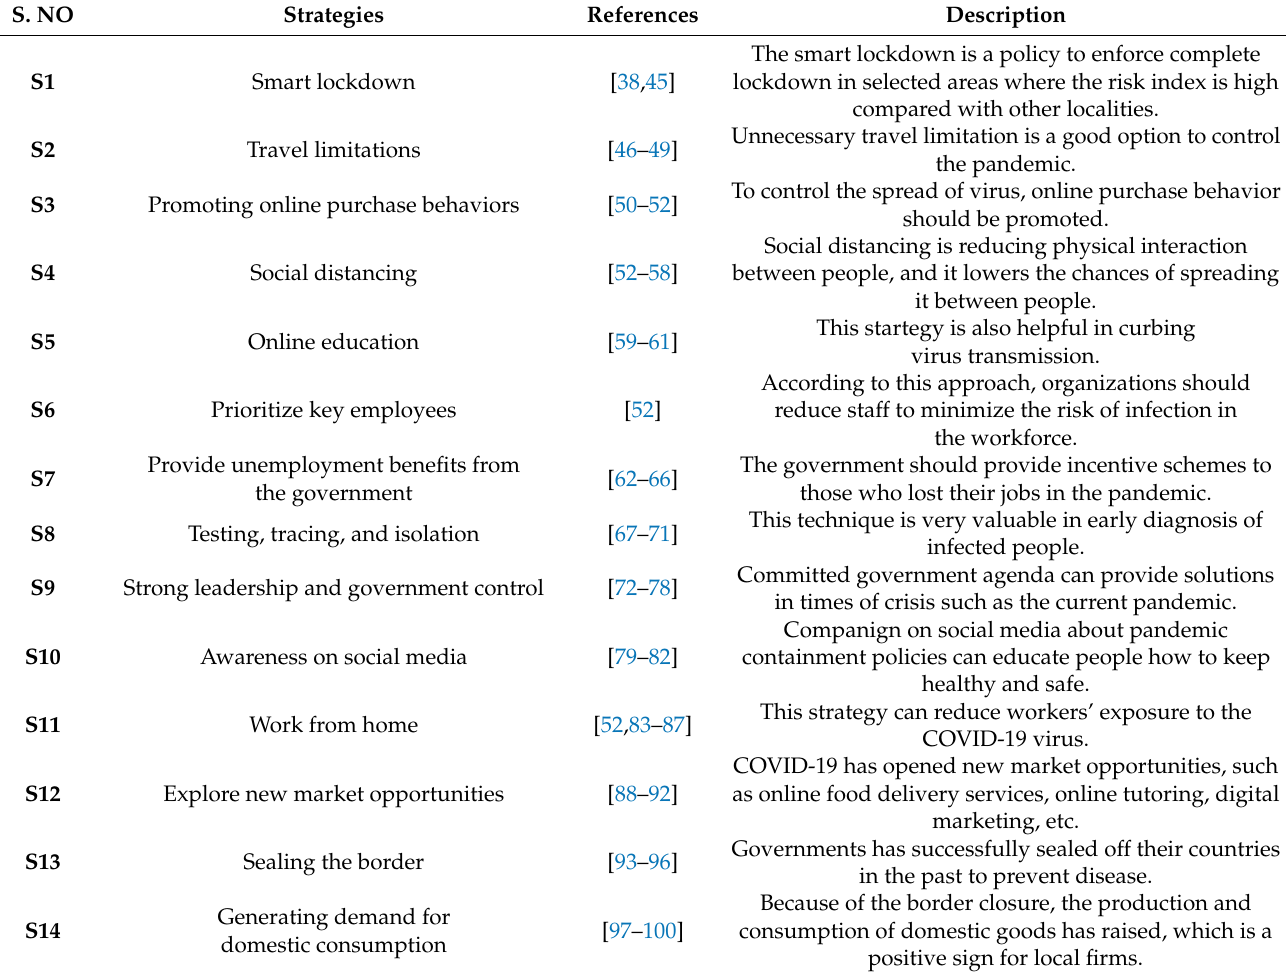
Table 1. List of identified strategies to counter pandemic